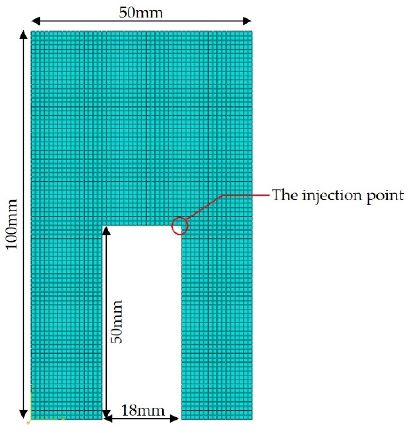
Figure 5. Model size.